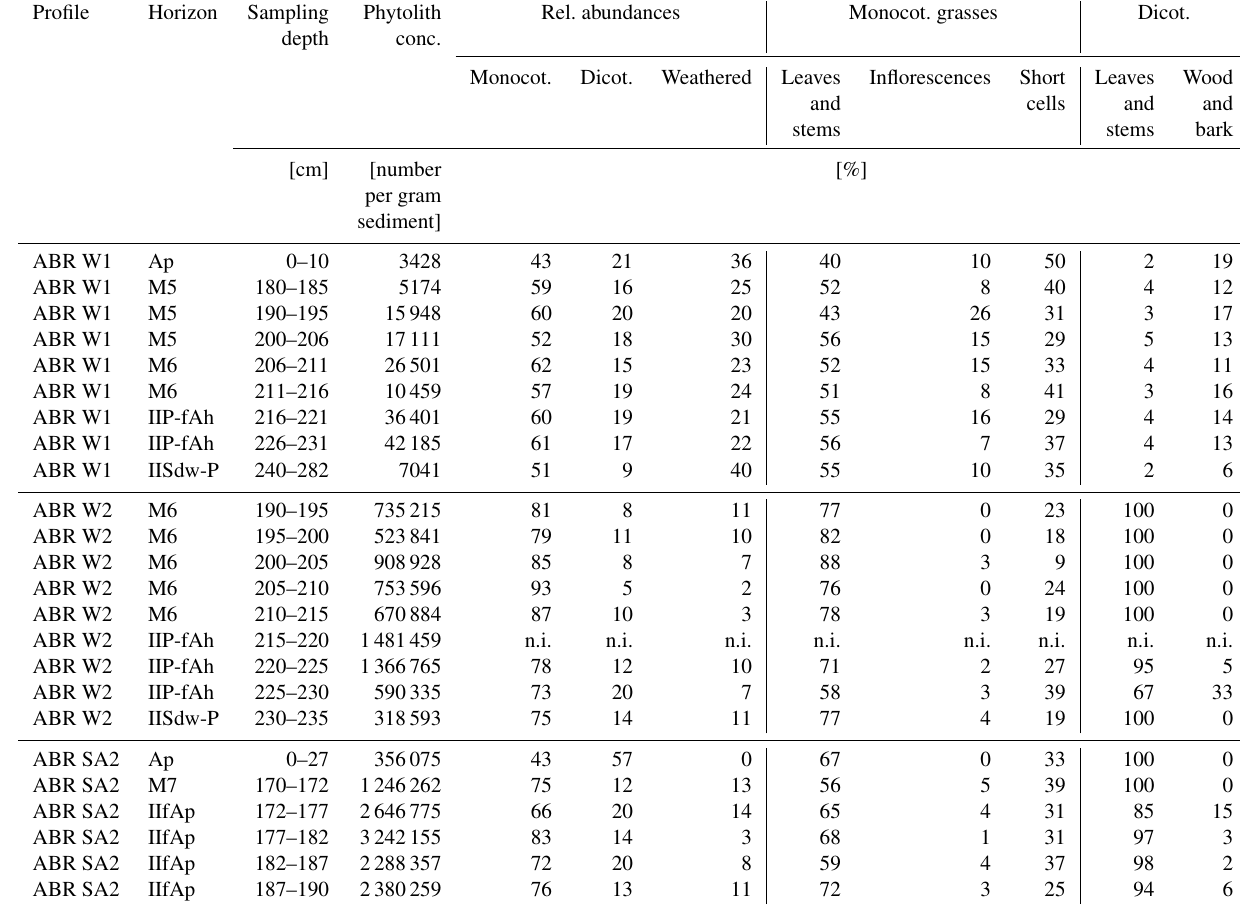
Table 2. Phytolith concentrations, relative abundances of phytoliths (monocotyledonous, dicotyledonous) and anatomical origin of phytoliths (grasses, dicotyledonous) of selected profiles. Percentages are calculated over the total number of morphotypes identified in each soil sample; at least 200 morphotypes were identified in each sample (n.i.: not